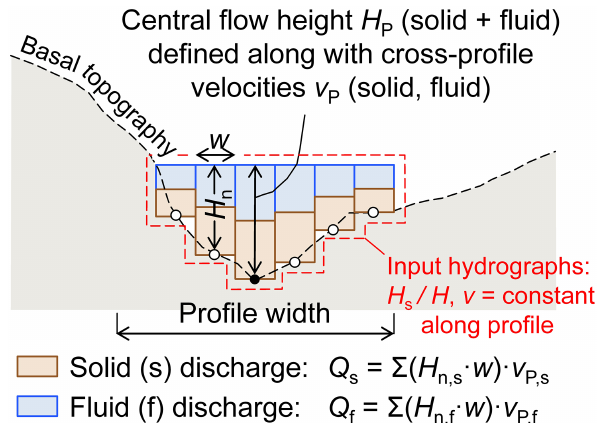
Figure 2. Sketch of a hydrograph profile. The flow surface of input hydrographs is defined by H P and is extended in cross-profile di- rection either to the edge of the profile or until it intersects with the basal